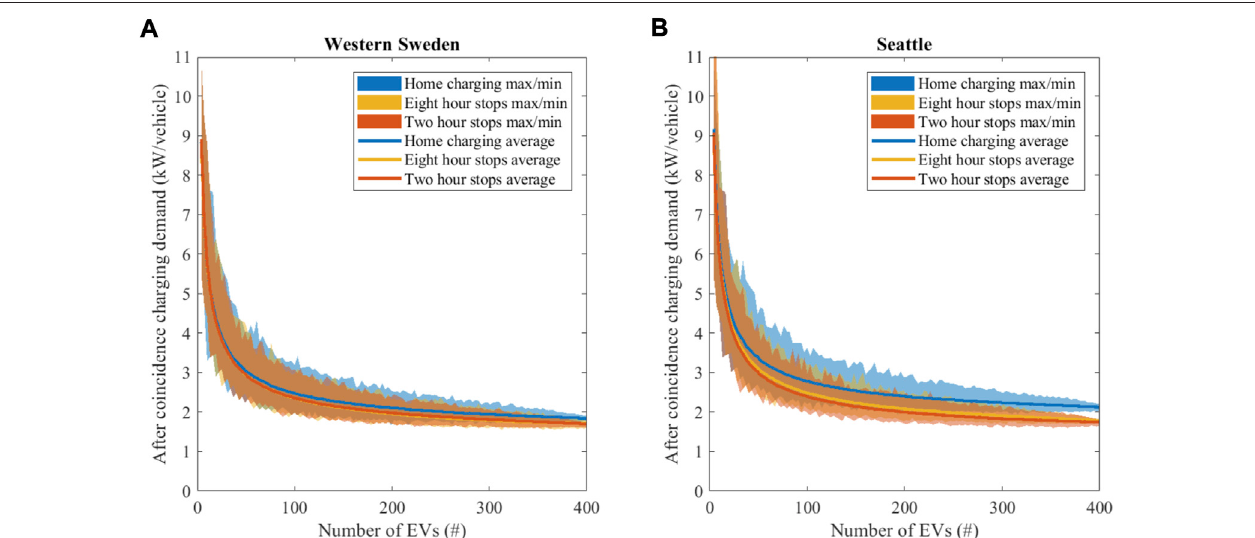
FIGURE2| After-coincidence charging power demandforthehighest houroftheyearand asanaverage forallcombinationofvehicles forthree differentcharging locations,(blue)charging athome location, (yellow), charging whenthecarisparked foratleast 8 hinarowand (red)chargingwhen thecarisparkedforat least2 hina row. The nominal charging power is 11 kW and the electricity demand per km is assumed to be 0.2 kWh/km. Data for Western Sweden in (A) and Seattle (B) . Shaded areas show variation (max and min) from the randomized combinations.